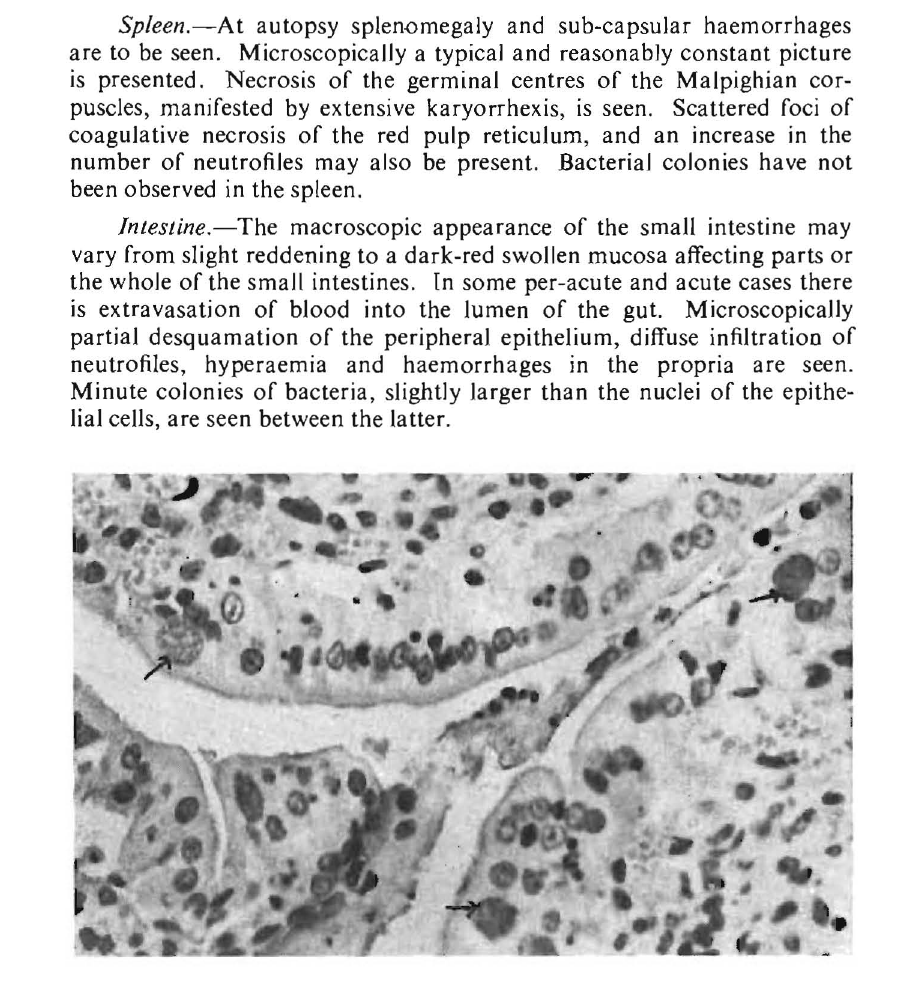
Fig. 6. Small intestine. Neutrofiles and red-blood cells in propria. Groups of bacteria, (arrows). Hand E staioing.